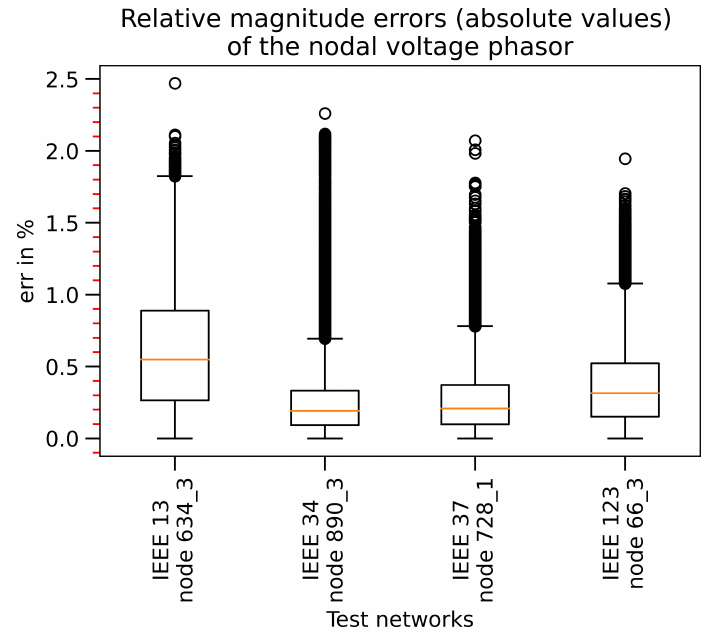
Figure 10. Distribution of percentage errors (absolute amounts) of nodal voltage phasor magnitudes for nodes with the highest errors obtained in Step B2. In Figure 11, the voltage phasor angles of estimated nodal voltages are presented.